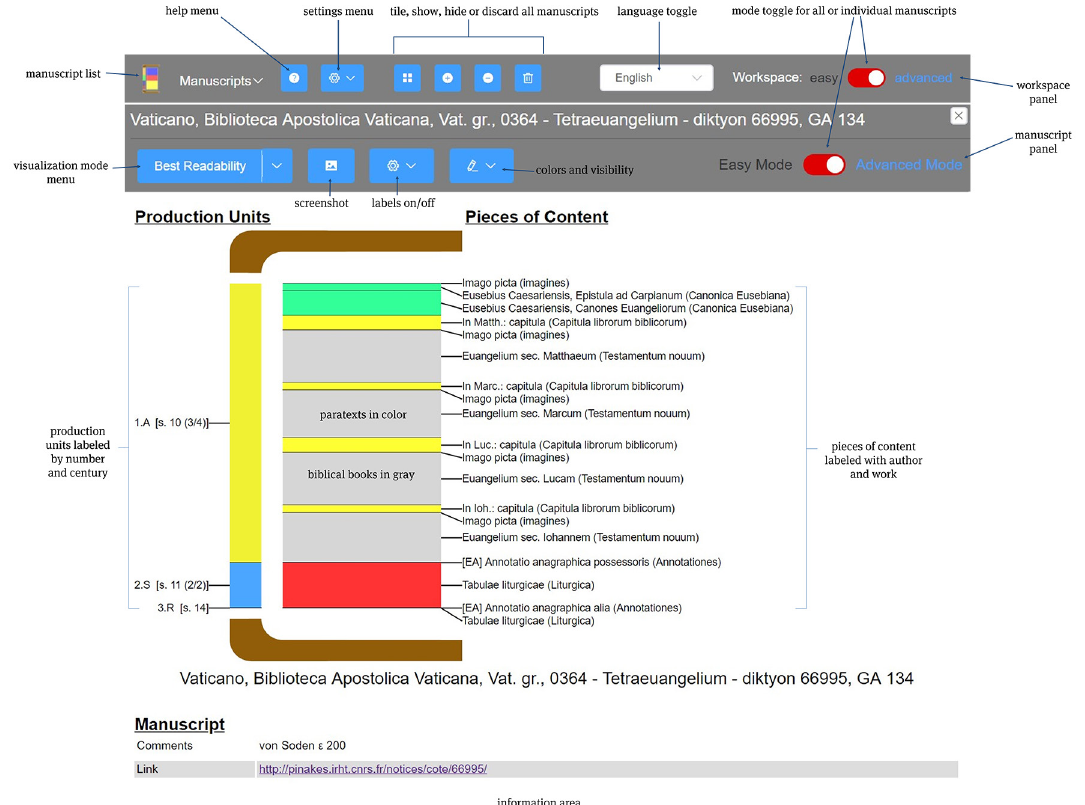
Figure 5. StruViMan Visualization of Vat. gr. 364